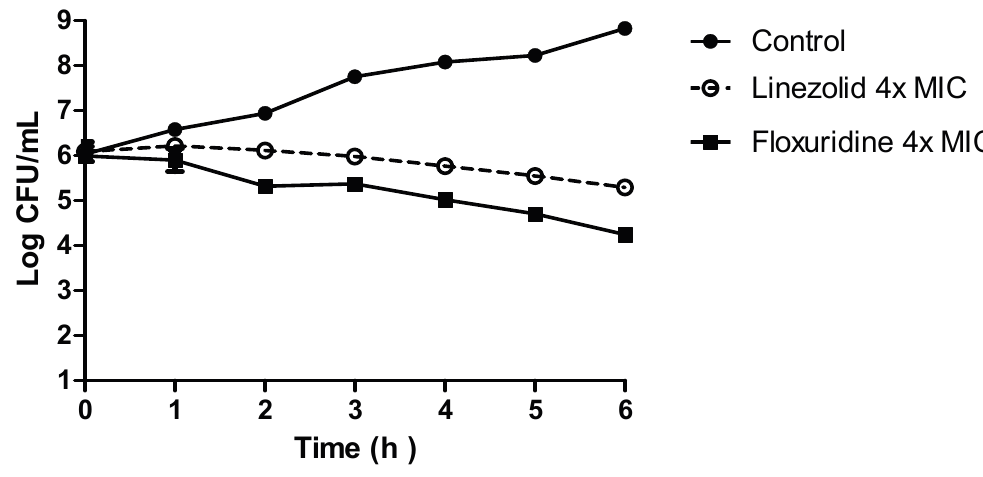
Figure 2. Bactericidal/static determination assay; left plate: Linezolid; right plate: Floxuridine.